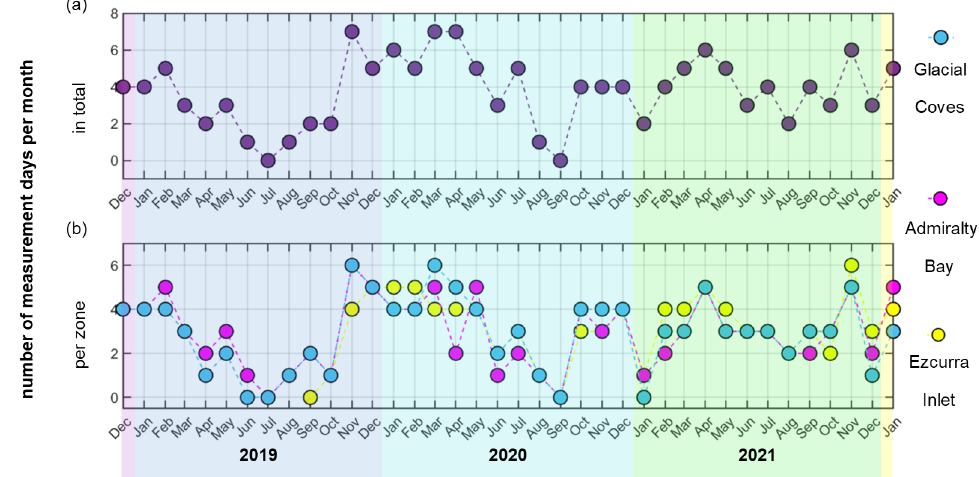
Figure 4. Number of measurement days per month (a) in total and (b) per zone (counted days on which measurements have been performed at at least half of zone’s